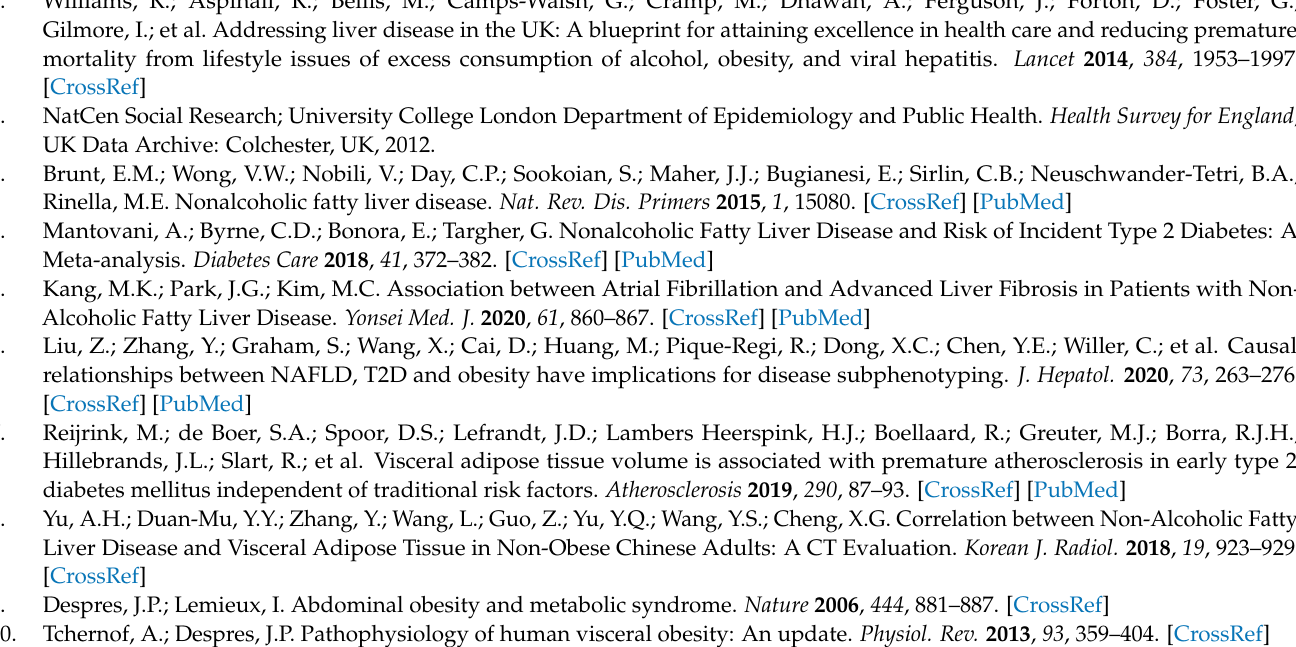
for fibrosis in patients with biopsy-proven non-alcoholic fatty liver disease. Table S2: Sex differences in baseline characteristics. Figure S1: (a) Cross-sectional computed tomography image at the level of the third vertebra to measure skeletal muscle and fat distribution. (b) Red and blue areas represent subcutaneous and visceral adipose tissues, respectively, and green area represents skeletal muscle. Figure S2: Flow diagram of the study. Figure S3: Association of adipose tissue distribution and skeletal muscle mass with hepatic steatosis, lobular inflammation, and ballooning degeneration. Figure S4: Receiver-operating characteristic curve of visceral adipose tissue index for advanced fibrosis, a. male; b. female. Figure S5: Correlation of skeletal muscle mass according to the fibrosis stage in obese patients with NAFLD. Figure S6: Correlation of visceral adipose tissue according to hepatic steatosis, a. male; b.